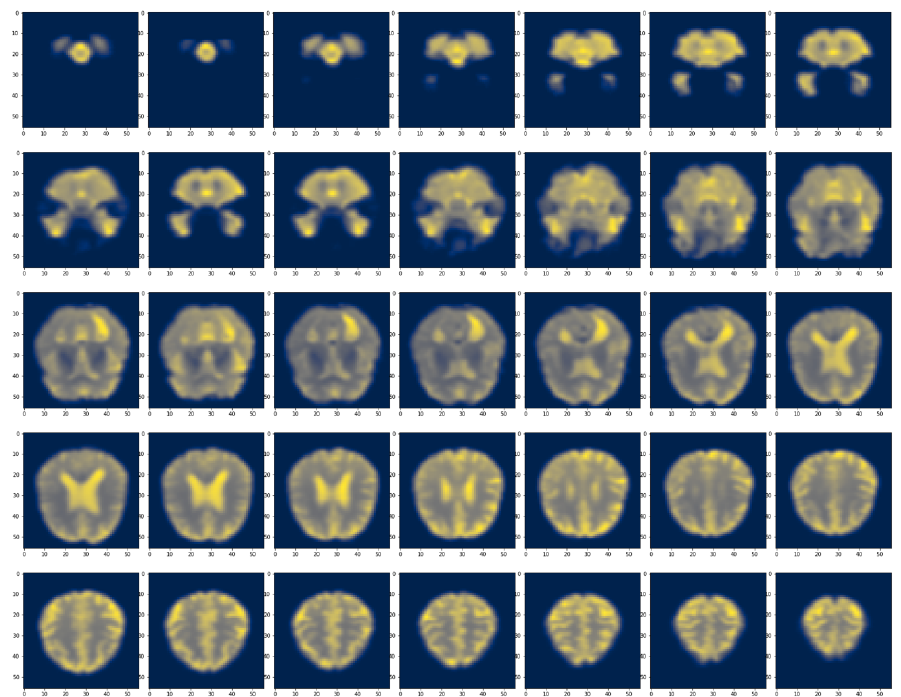
Figure 4. The global attention feature map was obtained by multiplying the FC layer vector by each pixel in the fMRI brain slices and measuring the sum of the multiplication per pixel. Next, we normalized the feature map to (0, 255) and visualized the maps using the CIVIDIS color map. Finally, we selected the first slice of each time-course to demonstrate various brain morphology across the fMRI data